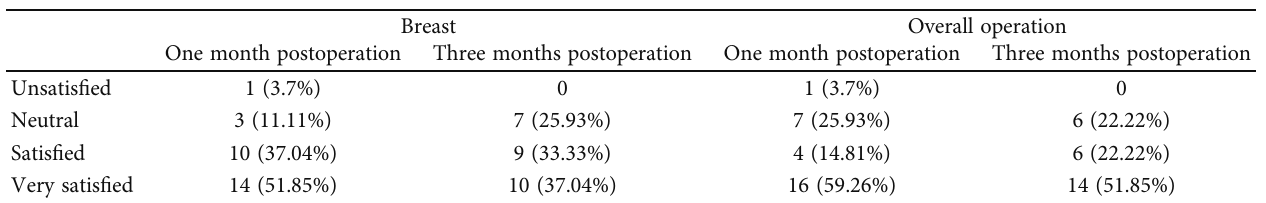
Table 3: Satisfaction with